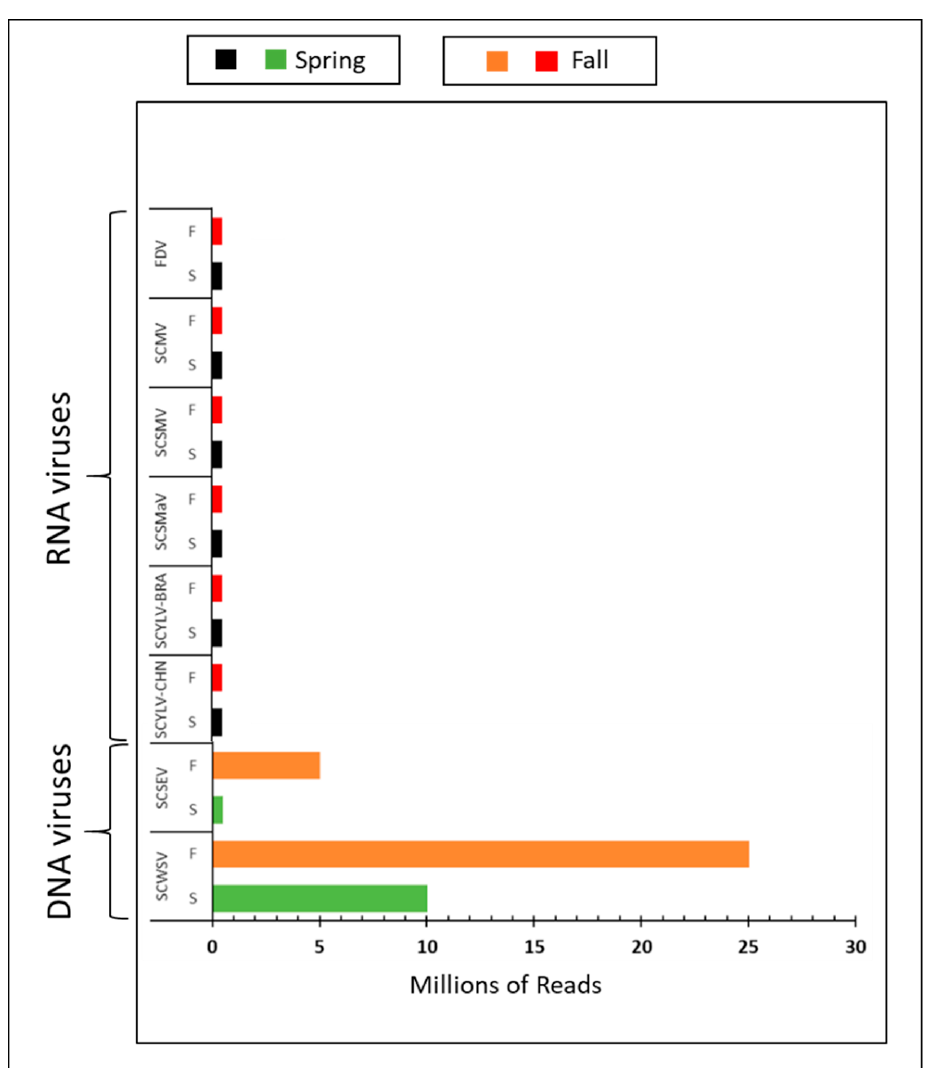
Figure 5. Sequencing depth required for RNA and DNA virus identification in spring and fall. Viral pathogens were identified using CLC Genomics Workbench to analyze randomly sub-sampled sets of 0.5, 1, 5, 10, 20, and 25 million reads. The limit of detection was defined as the smallest sub-sampled set in which mapped reads covered 60–80% (DNA viruses) or ≥ 80% (RNA viruses) of the best hit viral genome. The SCYLV-BRA genotype is represented by sample P1. The SCYLV-CHN genotype is represented by sample P2.